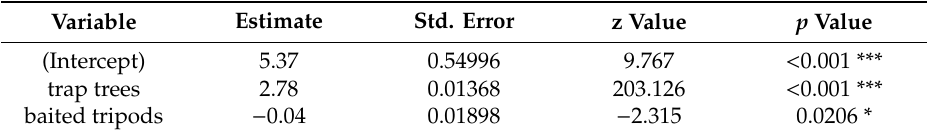
Figure 9. Numbers of I. cembrae captured by pheromone traps, trap trees, and tripods in experiment 5. The boxes indicate medians and interquartile range, and the whiskers indicate minimum and maximum values. *** and * indicate significance at p < 0.001 and 0.05, respectively. Table 9. Results of a generalized linear mixed model (GLMM) describing the relationship between the number of Ips cembrae beetles per trap and trap type method and study site as random effect in experiment 5. Corrected Akaike’s information criterion (AIC) = 67330. *** and * indicate significance at p < 0.001 and 0.05, respectively.